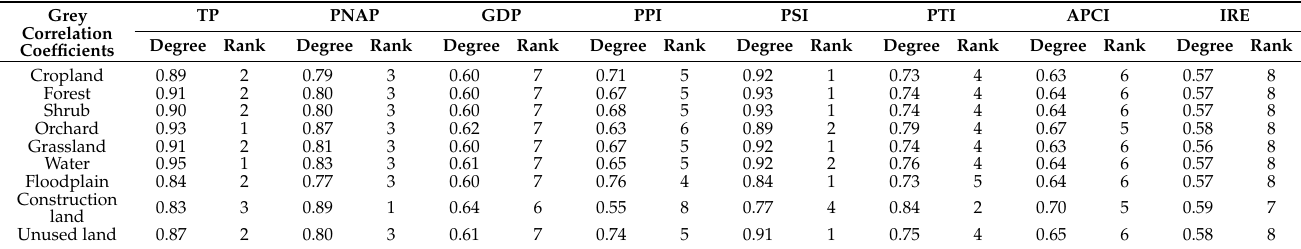
Table 3. Grey correlation coefficients of influencing factors on land use changes.